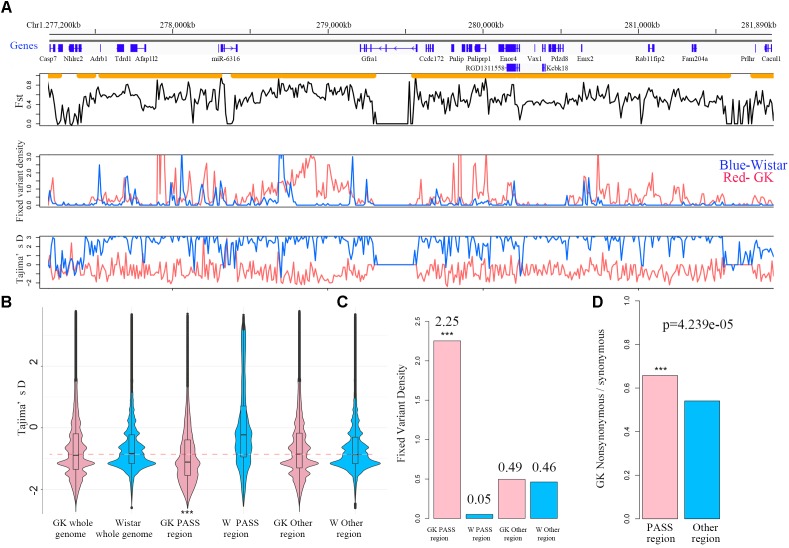
PASS regions in GK rats. (A) An example of the PASS region in GK rats. The gene distribution and the PASS regions (orange horizontal line) of the PASS region on chr1. Plot of the mean Fst in non-overlapping 10 kb between GK and Wistar rat across the PASS region. Distribution of fixed variant density and Tajima’D in non-overlapping 10 kb windows between GK (red line) and Wistar (blue line) rat in the examples of the PASS region. (B) Box plot of Tajima’D in non-overlapping 10 kb of whole genome, PASS and other regions between GK (pink) and Wistar (blue) rats. (C) The fixed variants density (variants count per 1 kb) of GK (pink bar) and Wistar (blue bar) rats in GK PASS region and other regions. (D) Ratio of the non-synonymous/synonymous of the PASS regions (pink bar) and other regions (blue bar) across the whole genome in GK rat. ∗∗∗p < 0.001.